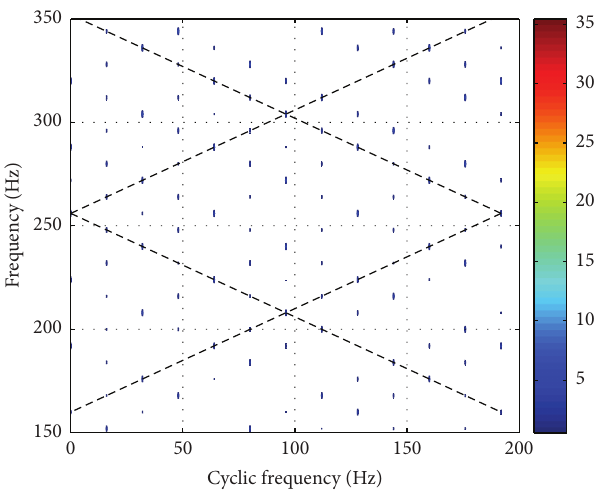
Figure 1: Cyclic spectrum distribution characteristics of an AM-FM signal.